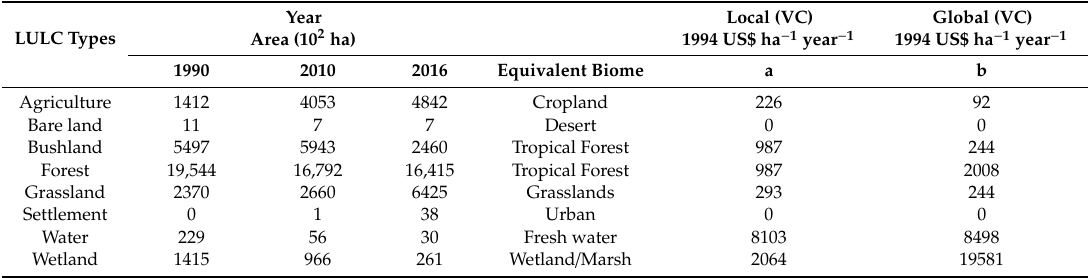
Table 1. Land use and land cover (LULC) types with their areas in increment of 10 2 ha for 1990, 2010 and 2016 adapted from Msofe et al. [29] and biome equivalents with their corresponding